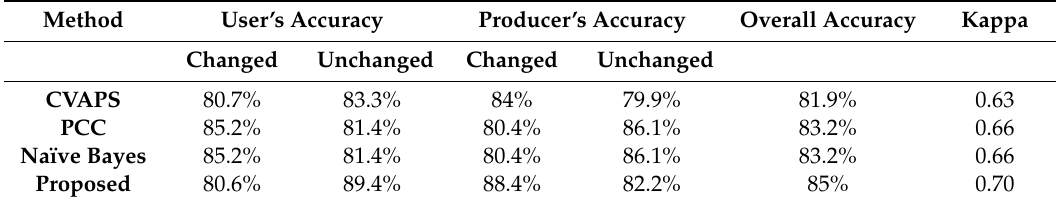
Table 1. Accuracy assessment of change detection in Experiment I.